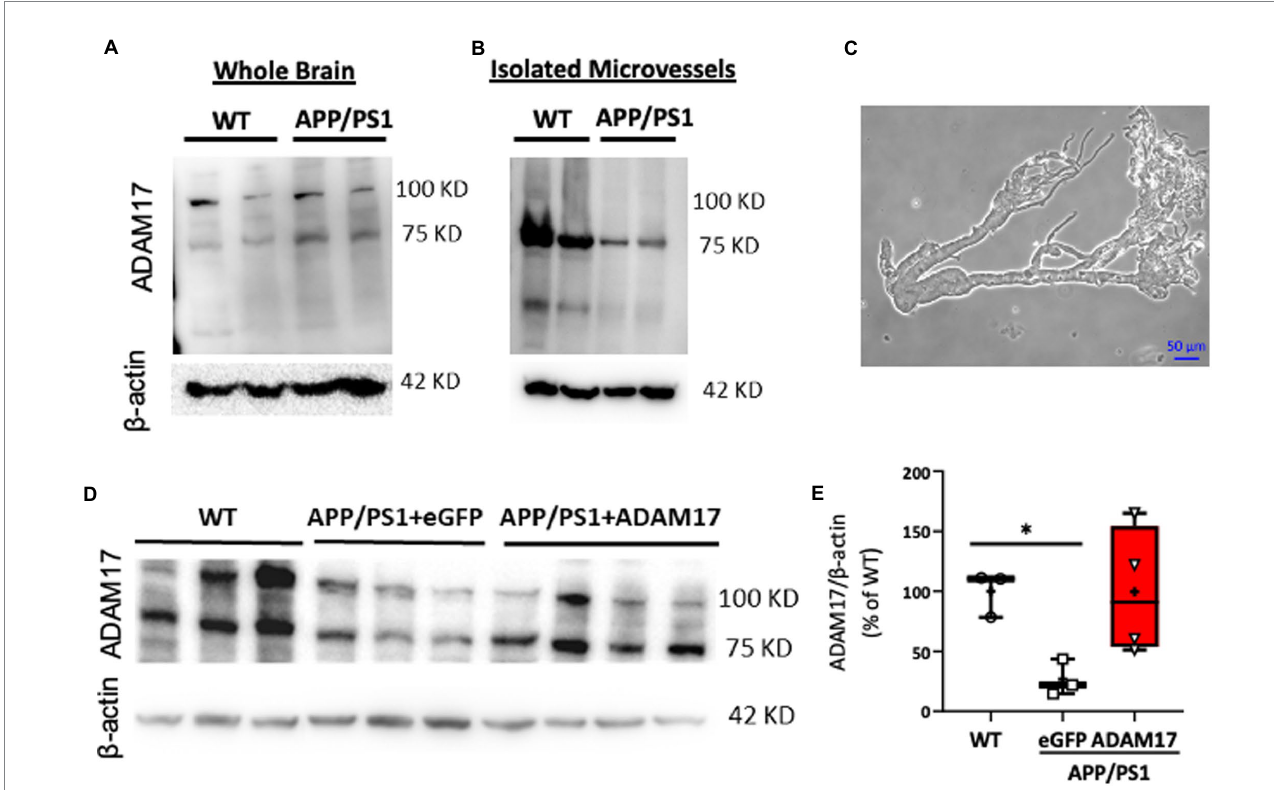
FIGURE 2 Reduced ADAM17 expression in cerebral microvessels of APP/PS1 mice is restored by ADAM17-AAV9. (A) ADAM17 expression was measured in whole brain lysates and (B) in isolated, purified cerebral microvascular preparations in WT and APP/PS1 mice. (C) Representative micrograph depicts a cerebral microvascular segment after centrifugation-based purification. (D,E) Representative image and quantification data of western immunoblots showing ADAM17 expression in cerebral microvessels of WT or APP/PS1 mice 3 months after injections with either eGFP-AAV9 or ADAM17-AAV9 virus. n =3 − 4. * P < 0.05. Two way ANOVA was